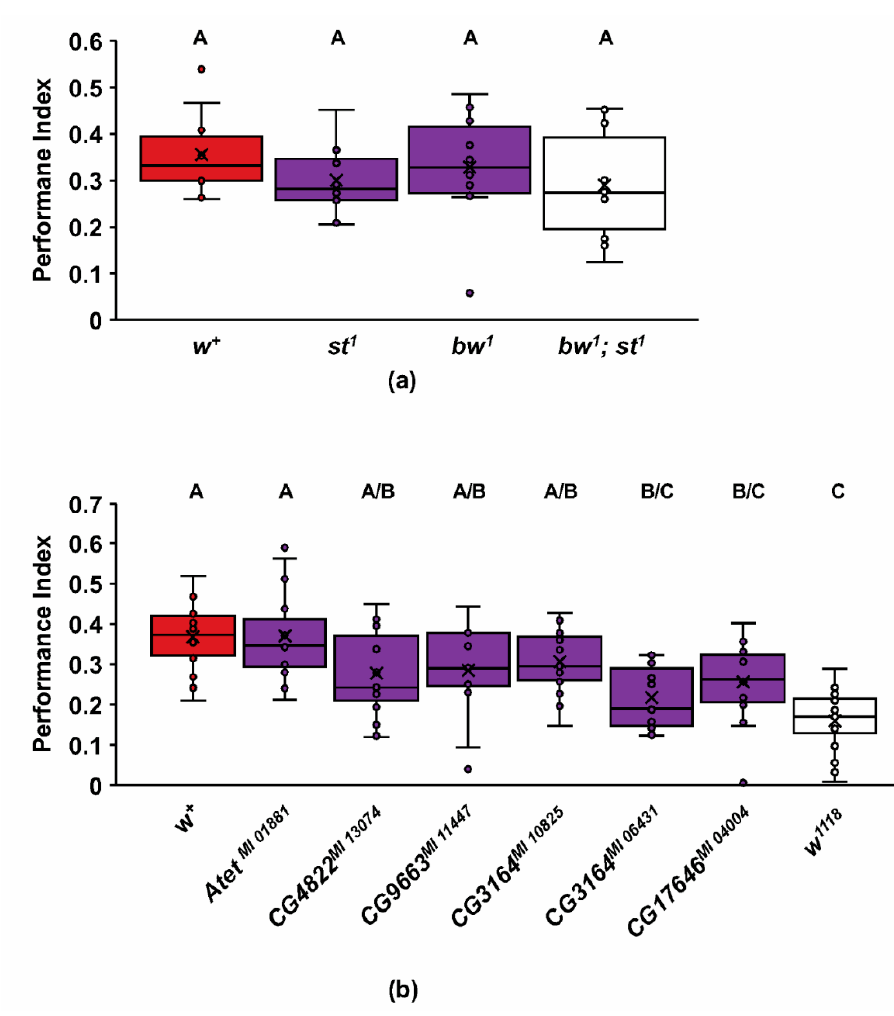
Figure 2. Assessment of one-trial learning in Drosophila ABCG mutants. ( a ) Outcrossed mutants of ABCG transporters scarlet ( st 1 ), brown ( bw 1 ), and bw 1 ; st 1 were not statistically different from wildtype ( w + ) (ANOVA, Adj R 2 = − 0.015, F 3,36 = 0.809, p = 0.497; Tukey post hoc, p < 0.05; n = 10); ( b ) the Atet MI 01881 , CG4822 MI 13074 , CG9663 MI 11447 , CG3164 MI 10825 , CG3164 MI 06431 , and CG17646 MI 04004 homozygous mutants were compared to both w + flies and w 1118 mutants. All ABCGs except Atet MI 01881 had lower acquisition performance than w + . CG3164 MI 06431 and CG17646 MI 04004 were both significantly different from w + and not different from w 1118 after Tukey post hoc analysis. (ANOVA, Adj. R 2 = 0.309, F 7,114 = 8.717, p < 0.0001; Tukey post hoc, p < 0.05; n = 15). Groups that do not share letters above the box plots are significantly different from each other according to the Tukey post hoc test ( p < 0.05).